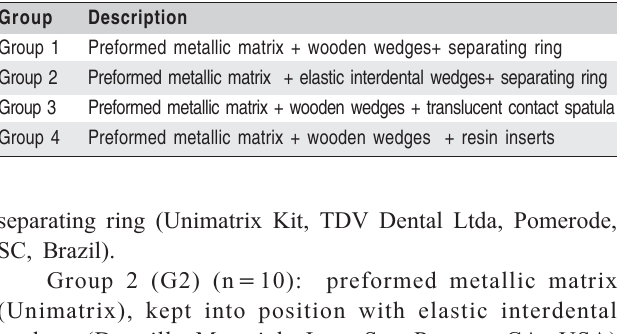
Table 2: Description of experimental